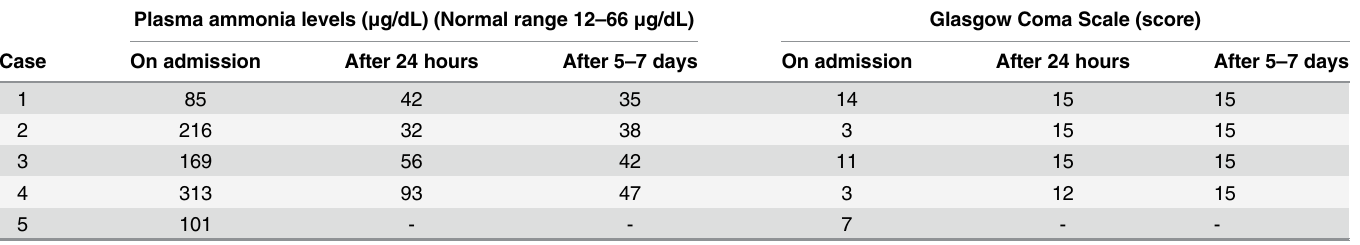
Table 5. Changes in plasma ammonia levels and level of